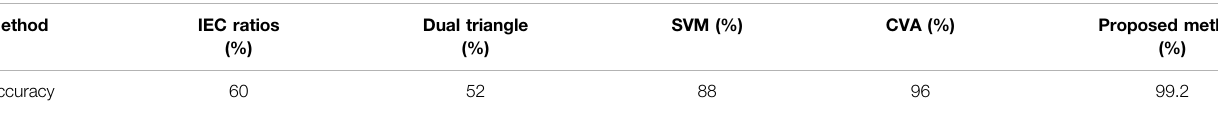
TABLE 7 | Result comparison with other